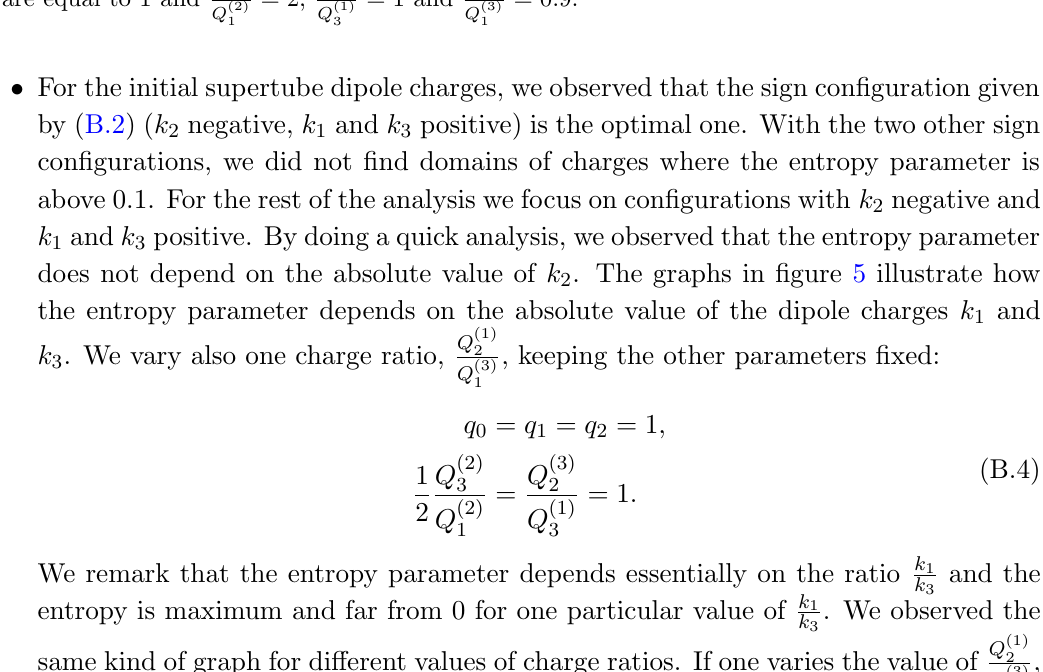
Figure 4 . The entropy parameter H as a function of the charges of V, q 0 , q 1 and q 2 with k 1 , (cid:0) k 2 , k 3 are equal to 1 and Q